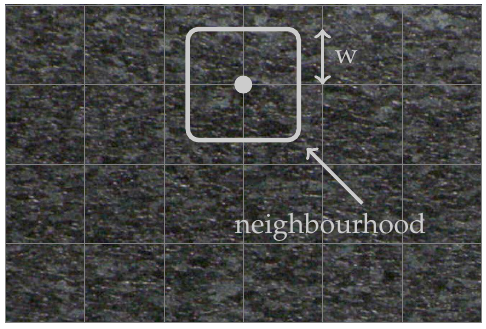
Figure 4. Grid and image excerpt selection for local scale-space